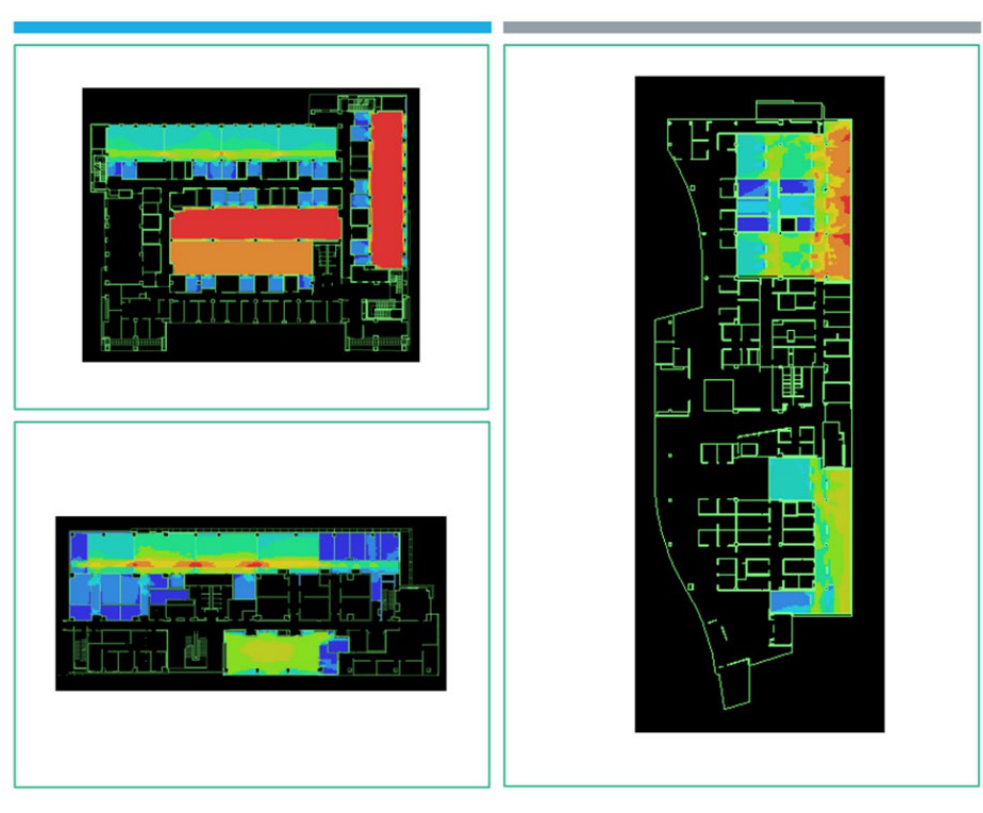
Figure 16 Visibility analysis of a typical laboratory and support room (Top left: Walther Hall, Bottom left: Neuroscience, and Right: